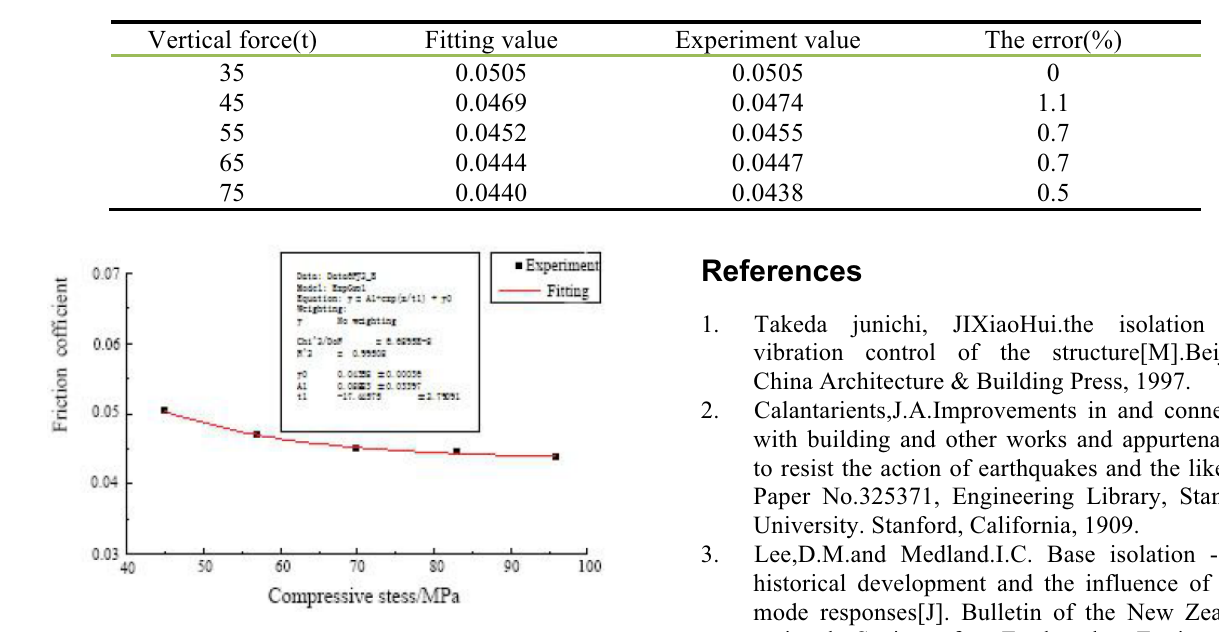
Figure 10. the curve of the friction factor and the compress